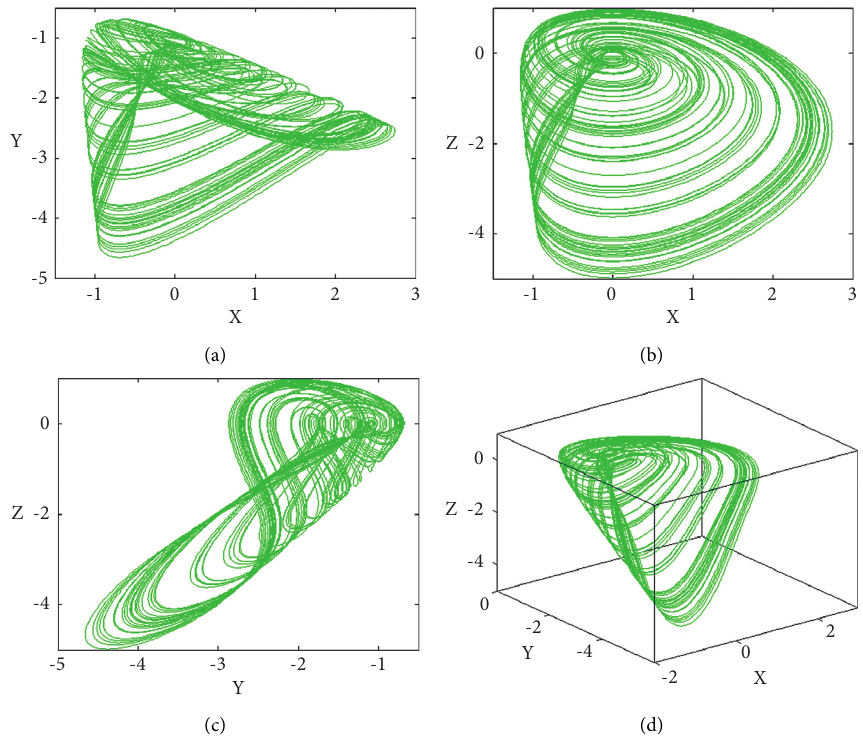
Figure 1: Chaotic attractor of system (1) with a � 0.9, b � 1, and c � 1 under initial condition IC � (2, − 2, 2): (a) ( x )-( y ), (b) ( x )-( z ), (c) ( y )-( z ), and (d) ( x )-(y)-( z